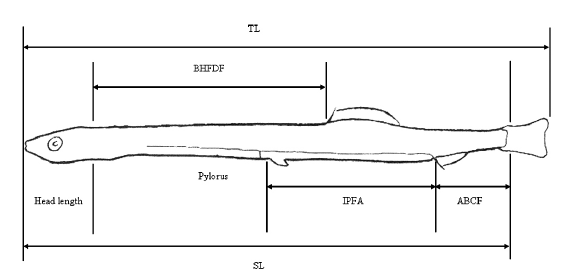
Fig. 1. – Diagram of sardine postlarva to illustrate body